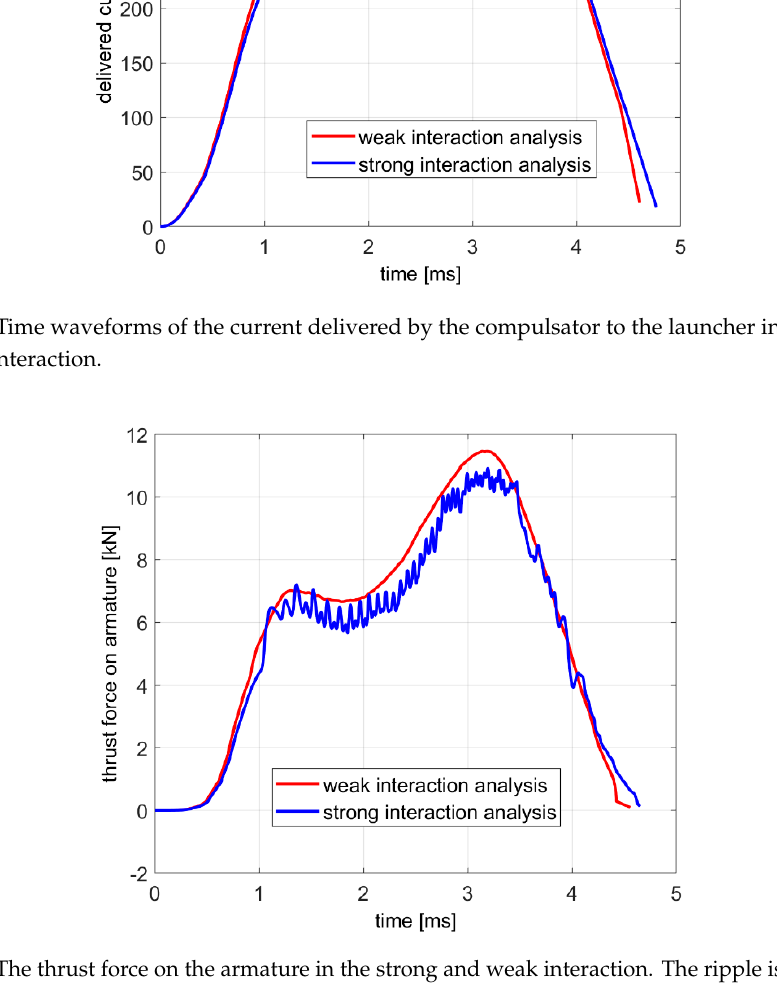
Figure 13. The torque on the rotor of the compulsator. The portion of the curve with positive value corresponds to recovering of magnetic energy as kinetic energy. The instant when the torque changes its sign is roughly the same as the one when the delivered current reaches its maximum. A decreasing current implies a reduction of the magnetic energy stored in the system. Part of this magnetic energy is converted in mechanical energy by increasing the speeds of the rotor of the compulsator and of the armature of the launcher. The remainder increases the temperature of the conductors. The weak interaction analysis produces a smoother waveform than that of the strong interaction one. The comparison of the speeds of the armature obtained by the two models is reported in Figure 14. The weak interaction analysis overestimates the speed of about 10%. The ripple in the thrust force